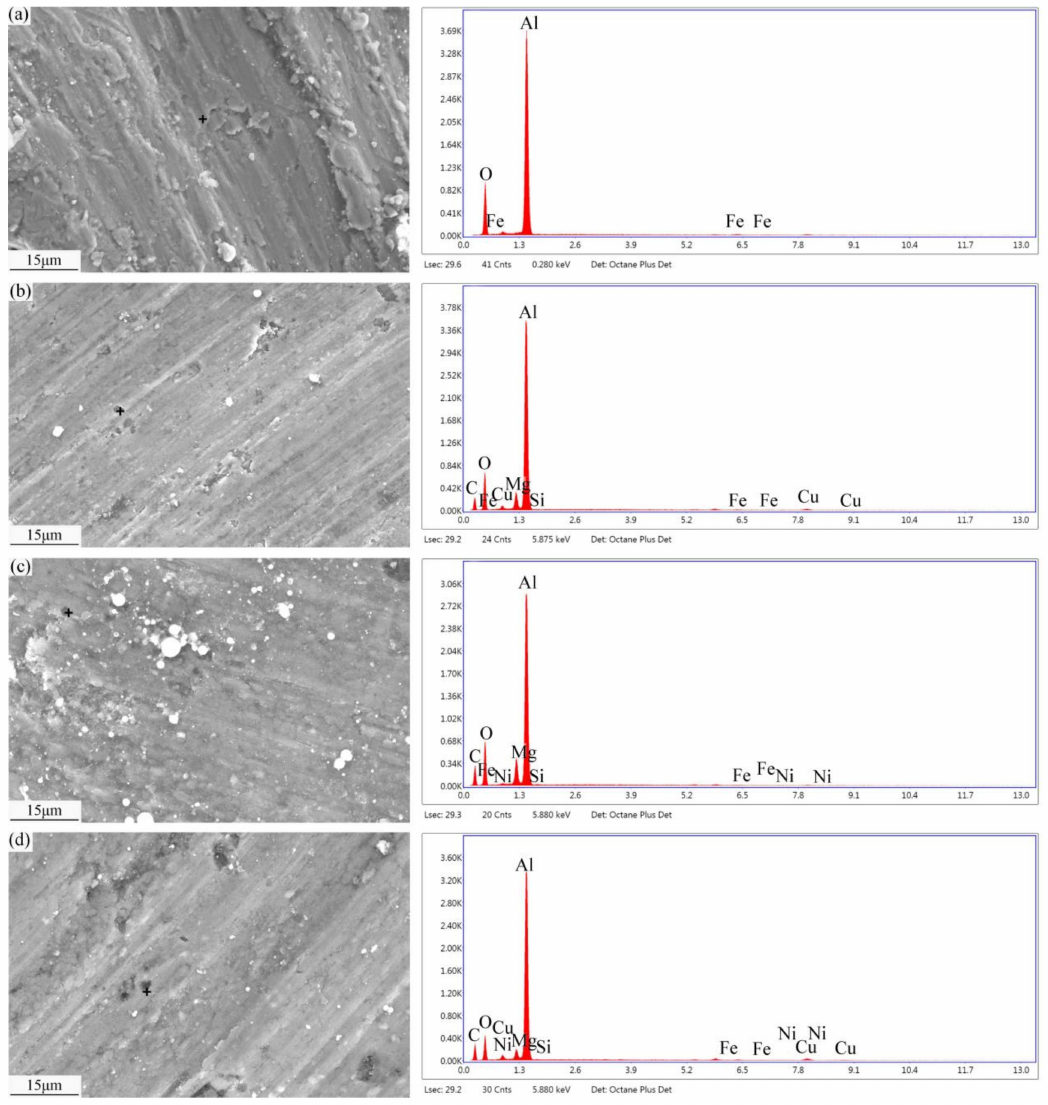
Figure 10. SEM images and EDS patterns of the worn surfaces of composites: ( a ) Al6061 alloy; ( b ) Cu-Cf / Al; ( c ) Ni-Cf / Al; and ( d ) Cu-Ni-Cf /